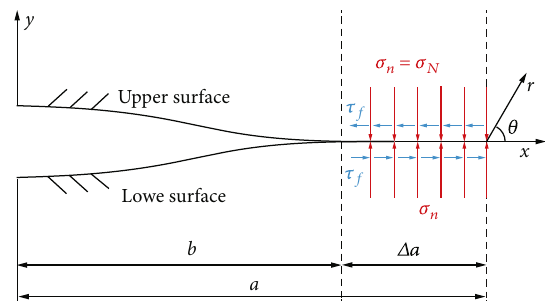
Figure 7: The surfaces in closed region subjected to the uniformly distributed compressive stress.